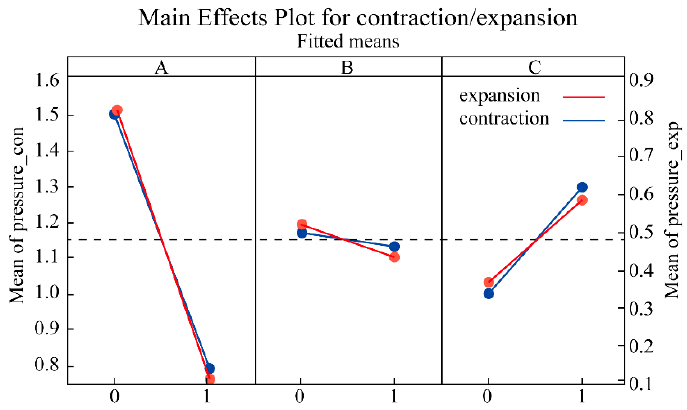
Figure 19. Main effect plot for expansion and contraction.